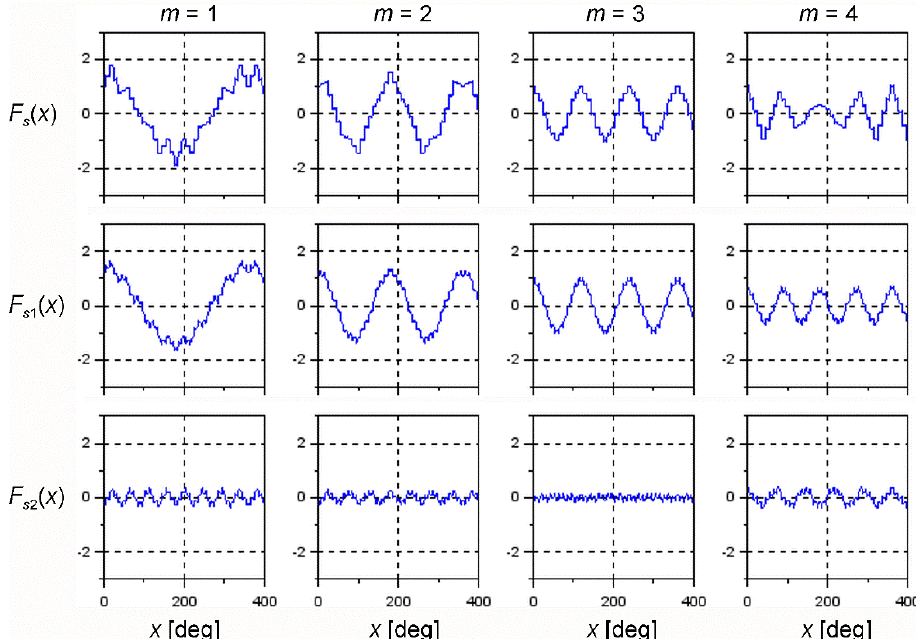
Figure 7. Distributions of MMF for nine-phase winding ( M = 9) of the first type ( S = 1) at t = 0, I μ = 1, and sequence numbers m = 1, 2, 3, and 4.